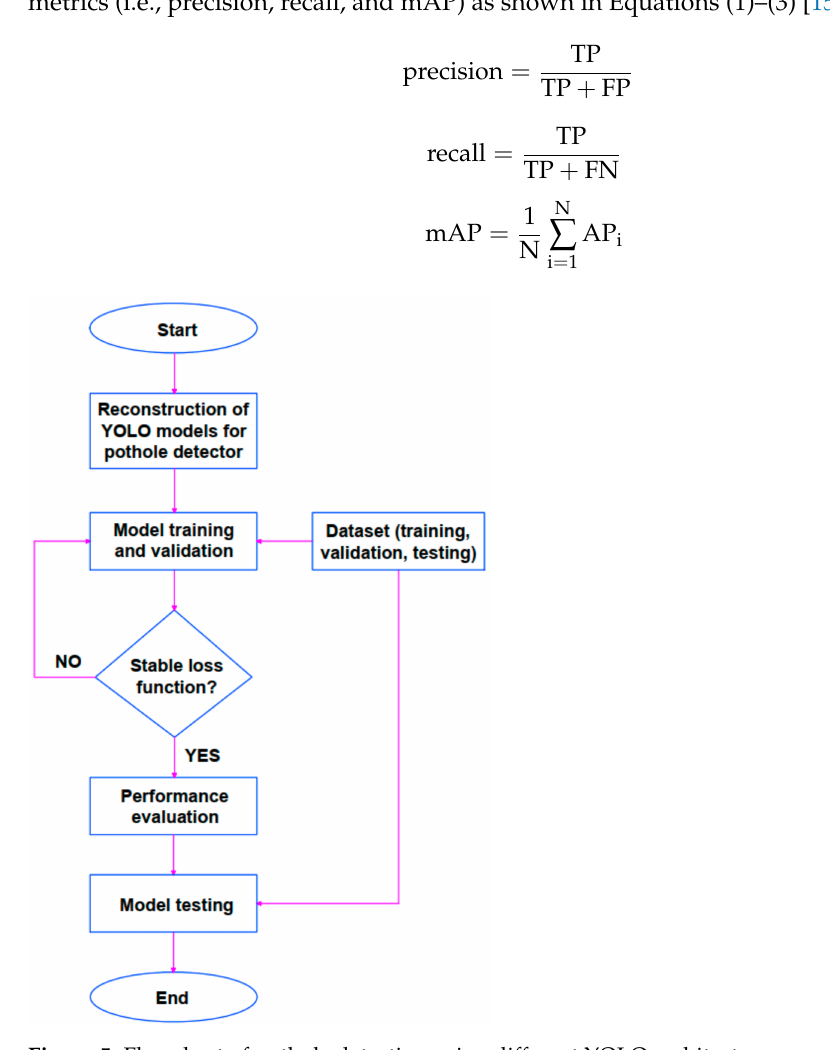
Figure 5. Flowchart of pothole detection using different YOLO architectures.